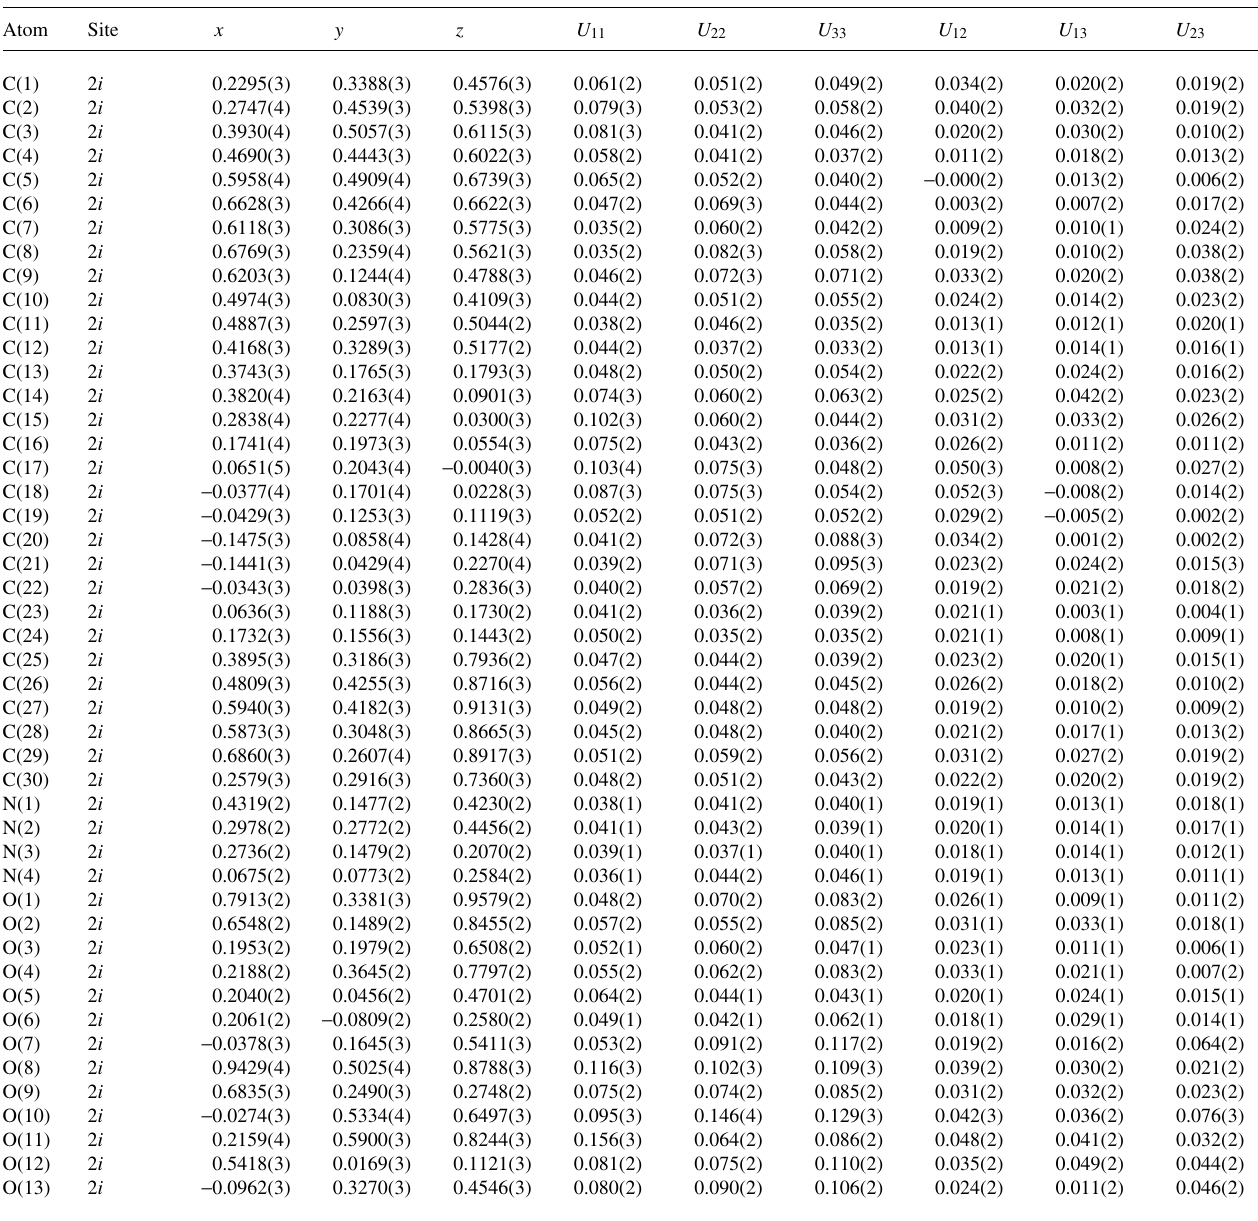
Table 3. Atomic coordinates and displacement parameters (in Å 2 )